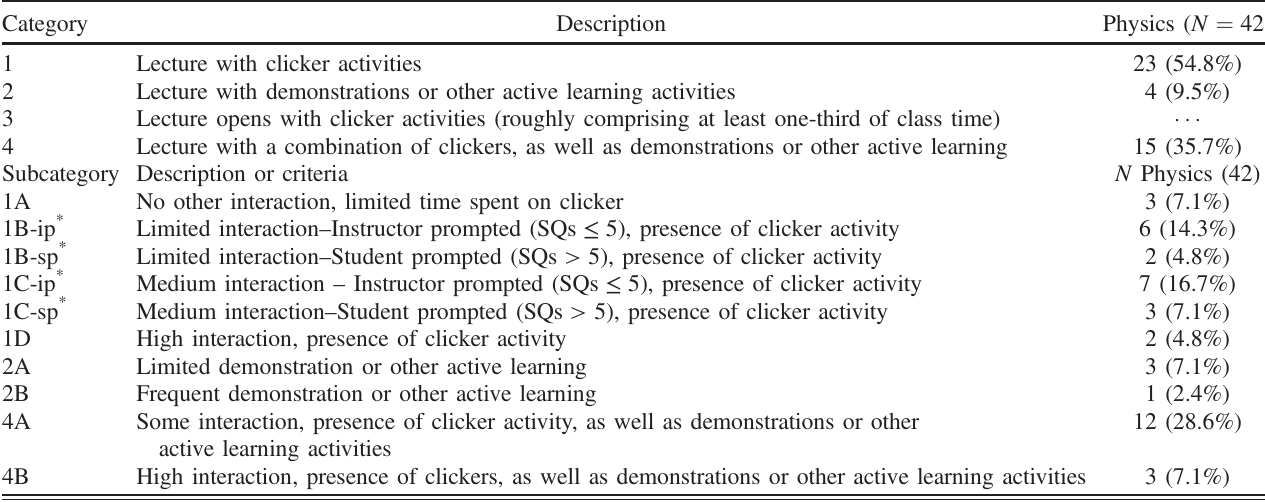
TABLE II. Categories and subcategories by number of observations for introductory physics courses.